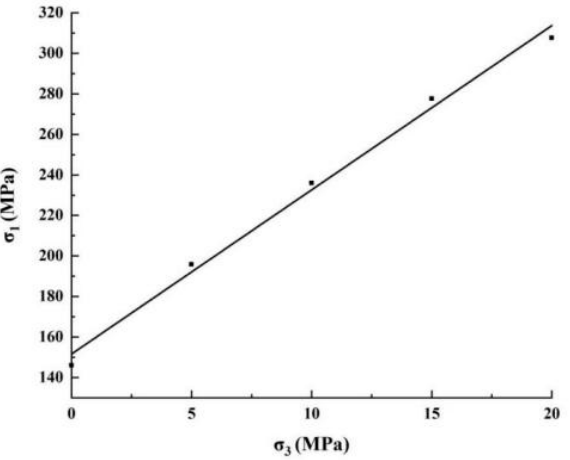
Figure 7. The curve of axial stress changes with confining pressure.